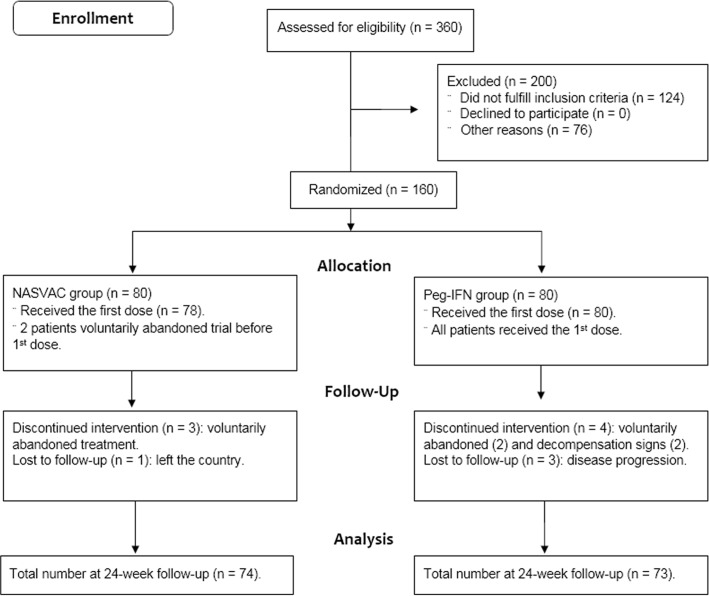
CONSORT 2010 flow diagram.Flow diagram following CONSORT guidelines, comprising the steps of patient enrollment, allocation and follow-up.